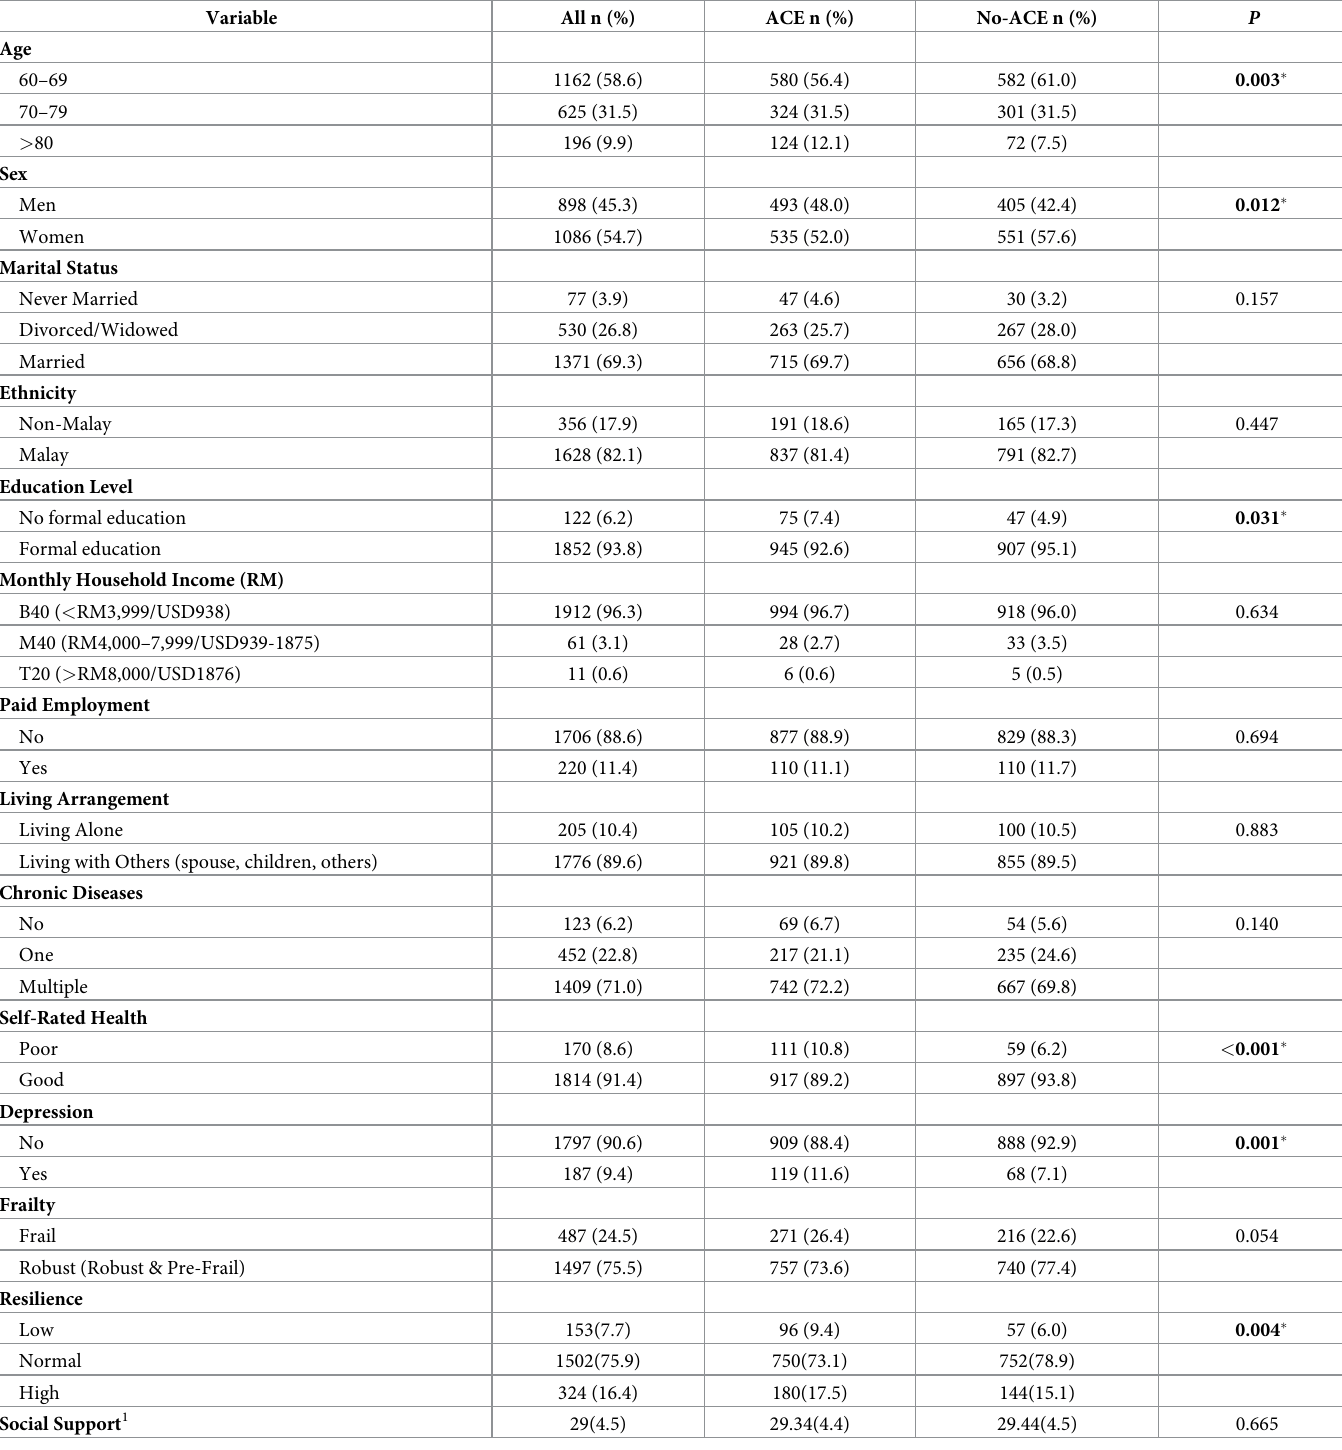
Table 1. Basic characteristics of study